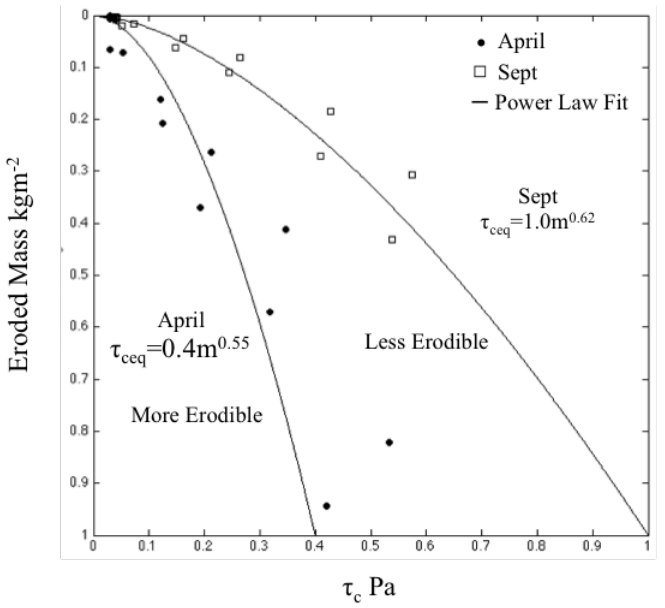
Figure 2. Profiles of τ obtained by power law fit to observations (as in [33]). Power law ceq fit to observed (solid lines) critical stress profiles for April and September, 2007. Triangles and asterisks show observed data from